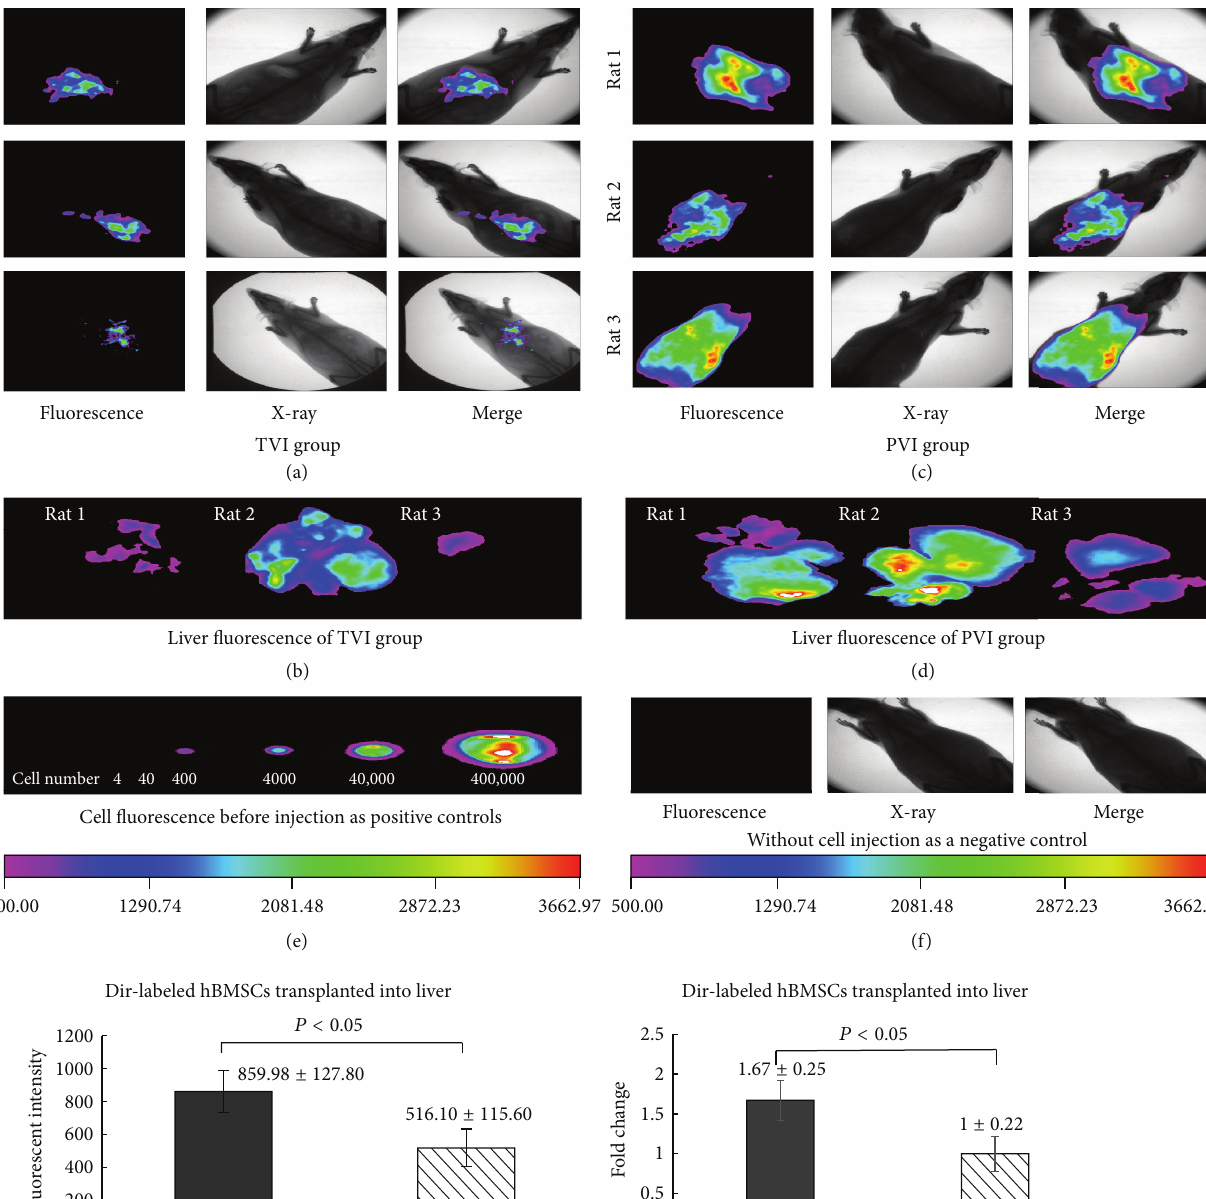
Figure 4: Difference between portal vein injection and tail vein injection. (a) The fluorescent intensity of whole rats; the BMSCs were injected through tail vein; (b) the fluorescent intensity of dissected livers; the BMSCs were injected through tail vein; (c) the fluorescent intensity of whole rats; the BMSCs were injected through portal vein; (d) the fluorescent intensity of dissected livers; the BMSCs were injected through portal vein; (e) Dir-labeled BMSCs before injection were as positive control; (f) rats without cell injection were as negative control; (g) the fluorescent intensity value and fold changes of the dissected livers of two groups; the difference was statistically significant.